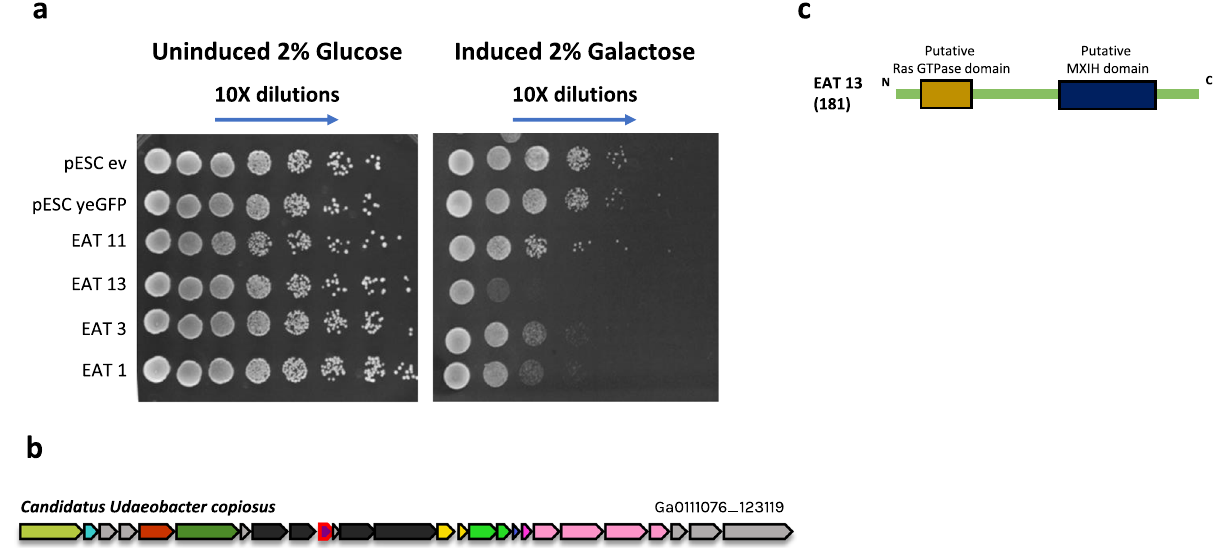
Fig. 6 EATs are toxic to S. cerevisiae . a EATs were cloned into pESC -leu Galactose inducible plasmids that were then transformed into Saccharomyces cerevisiae BY4742 strain. Overnight cultures of the strains harboring the vectors of interest were grown in SD -leu media. The cultures OD was normalized and then washed once with water and split into two: one part was grown overnight in repressive conditions (SD -leu + 2% glucose) and the other part was grown in inductive conditions (SD -leu + 2% galactose). Dilutions were spotted on SD -leu plates containing glucose or galactose and the plates were incubated two nights at 30 °C. Negative controls: empty vector (ev) and non-toxin (yeGFP gene). Three biological replicates of this experiment are presented in Supplementary Fig. 25. b Operon containing EAT13 toxin (outlined in red border). Gene color code matches that of genes in Fig. 4a. c EAT13 protein domains with predicted